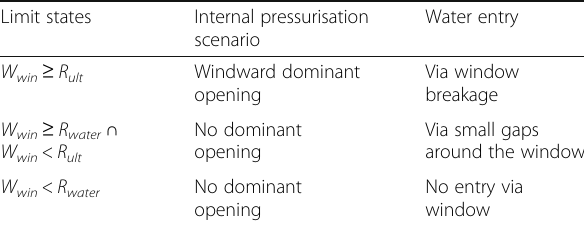
Table 3 Limit states for the windward window Limit